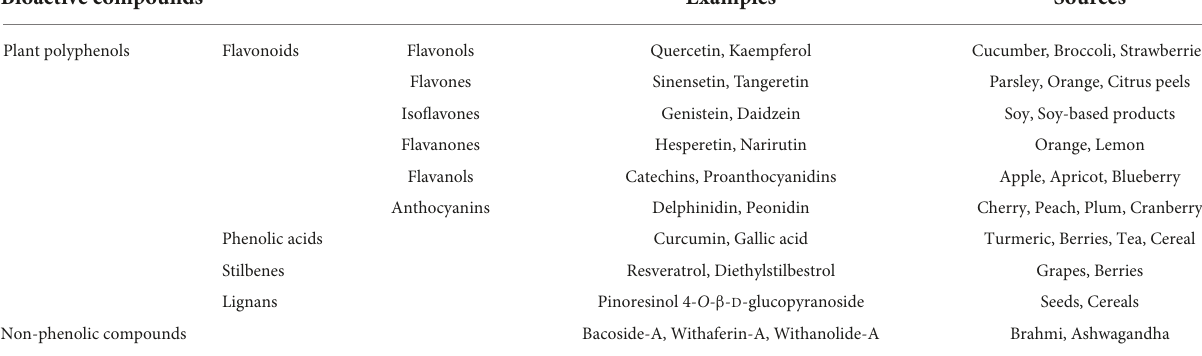
TABLE 1 Major plant-derived bioactive compounds and their